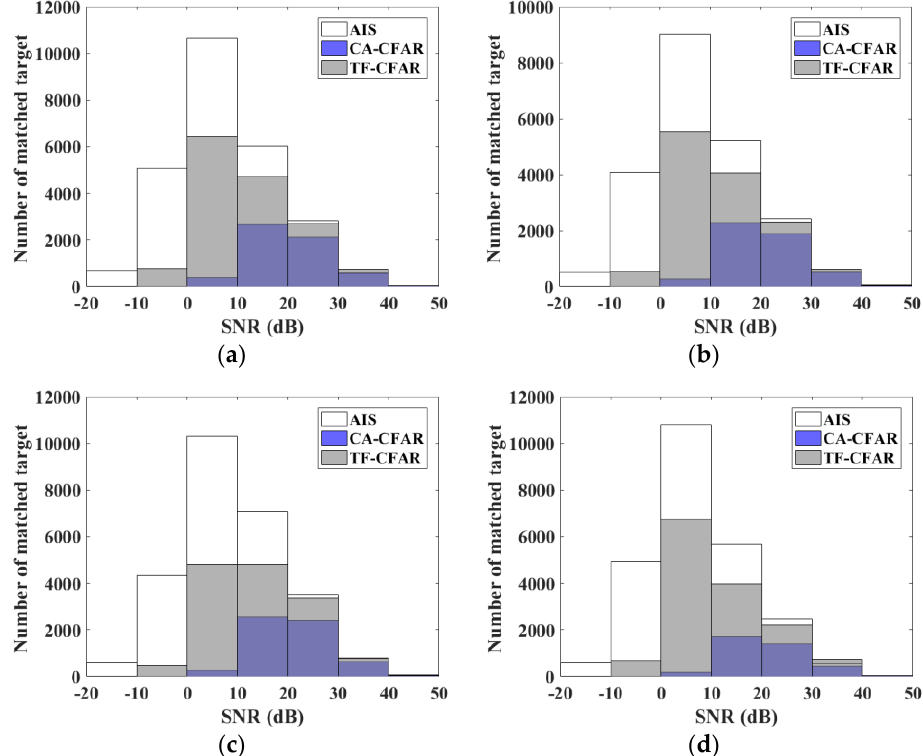
Figure 12. Matched targets versus SNR by TF-CFAR and CA-CFAR on ( a ) 24 September, ( b ) 25 September, ( c ) 26 September, and ( d ) 27 September.